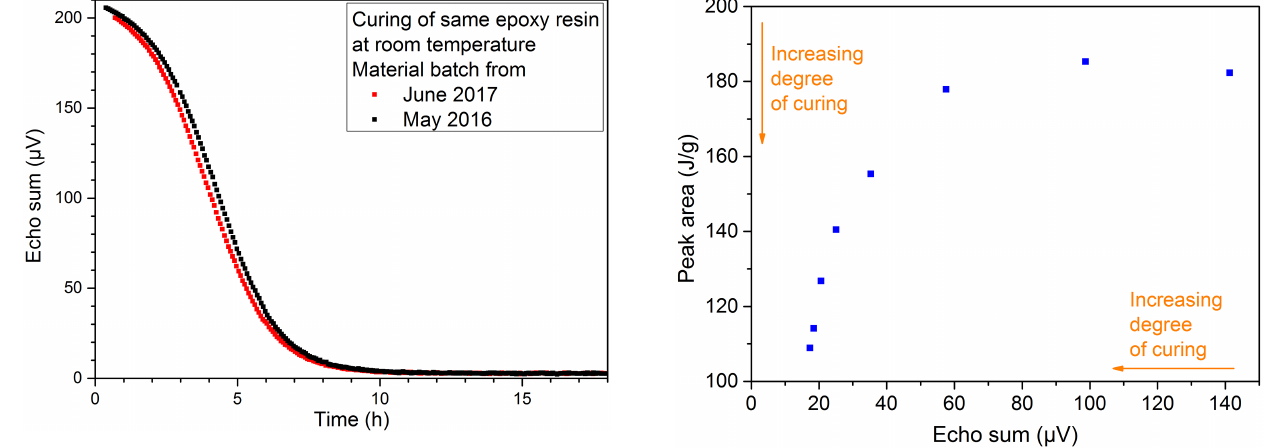
Figure 17. Curing of two different material batches of EP resin at room temperature.